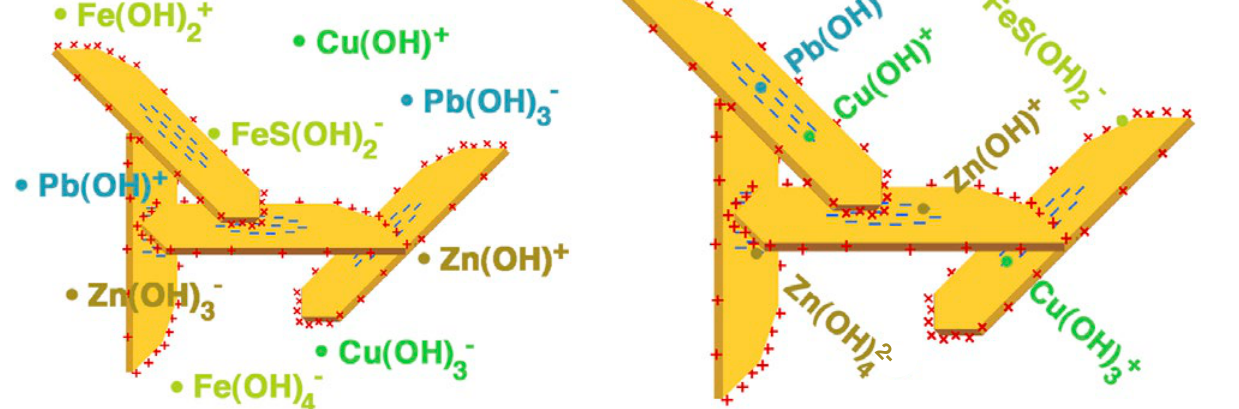
Figure 65. Trace metals are dissolved and leached from soils and rocks by weathering processes. This diagram illustrates a dispersion of hydrolysed metal ions with a simple clay floc but many different particles and surfaces adsorb metal ions from stream water.